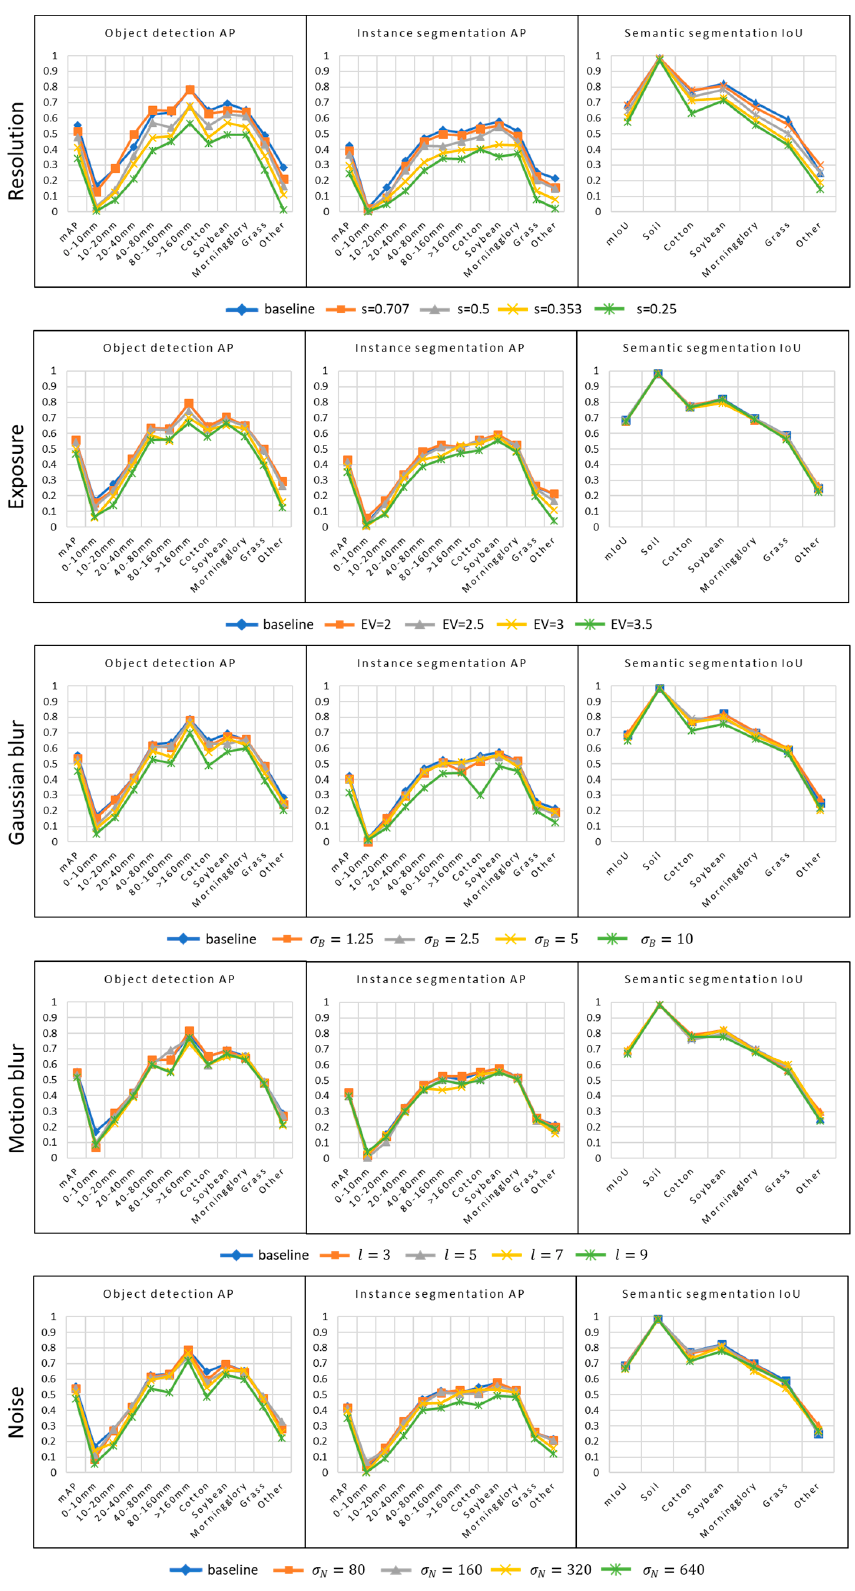
Figure 8. The influence of resolution, overexposure, Gaussian blur, motion blur, and noise on the performance of Faster R-CNN, Mask R-CNN and Deeplab-v3 for object detection, instance segmentation and semantic segmentation.